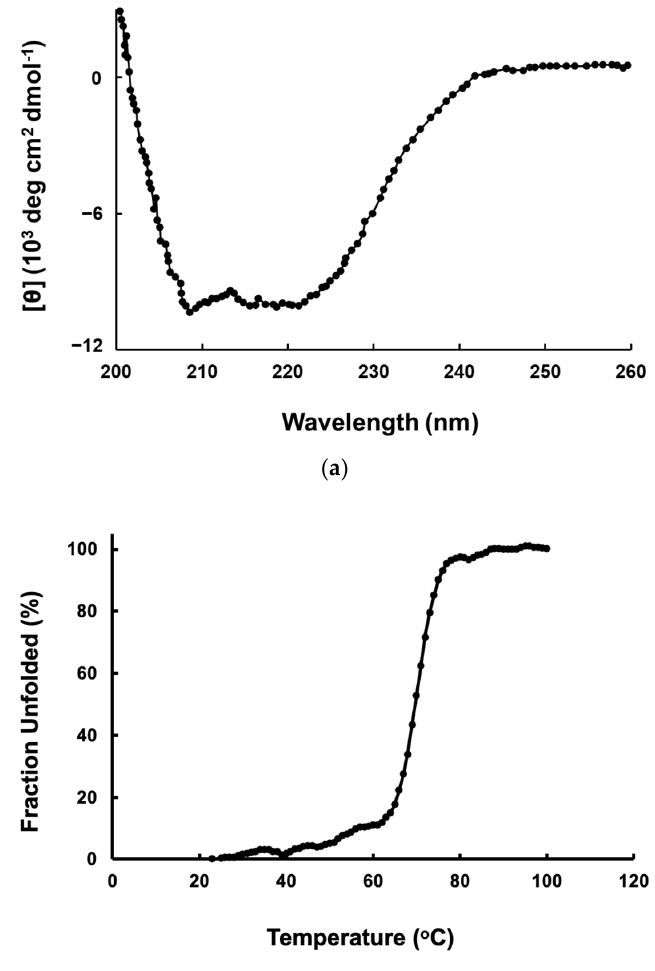
Figure 4. ( a ) Far-UV CD spectrum of ClpP from Plasmodium knowlesi (Pk-ClpP). ( b ) Unfolding curve of Pk-ClpP observed under the changes of CD value at 222 nm from 20–100 °C.